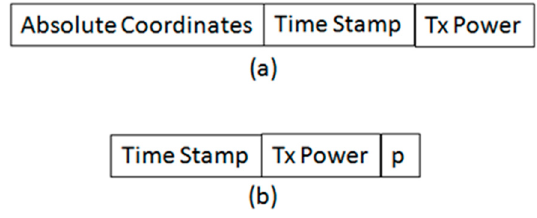
Figure 3. ( a ) Format of Localization Beacon, and ( b ) Format of localization Figure 3. ( a )Format of Localization Beacon, and ( b ) Format of localization Request.